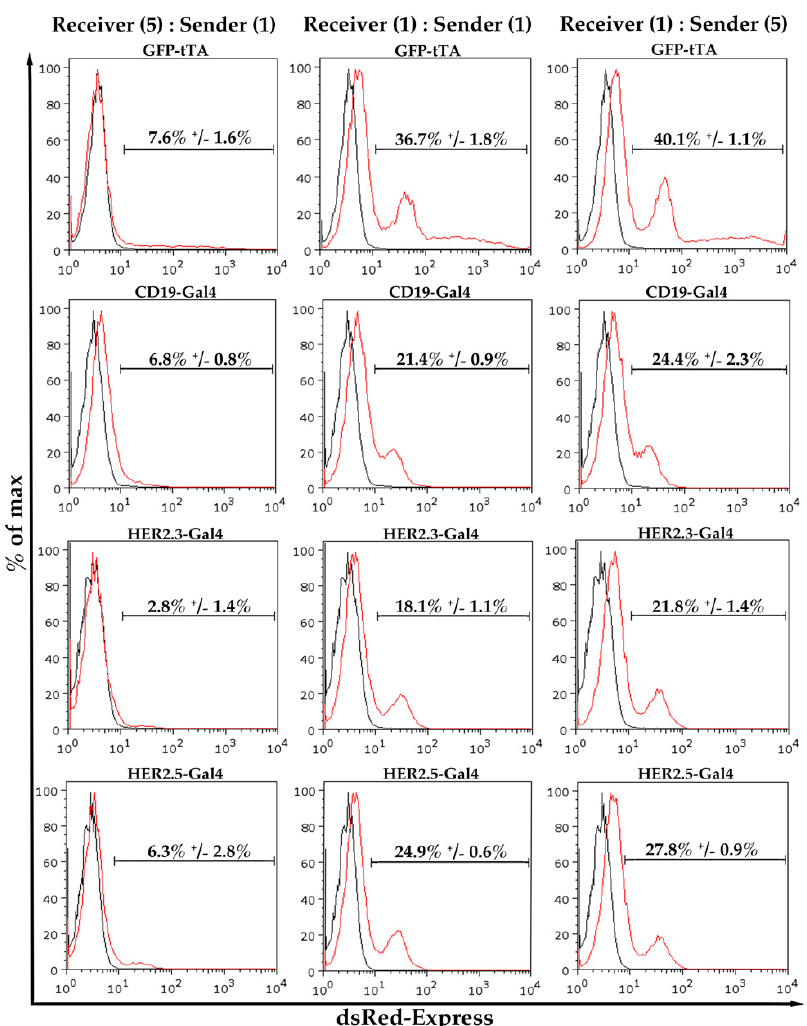
Figure 2. Effect of the ratio of receptor-presenting receiver cells to antigen-presenting sender cells on synNotch receptor activation: To determine the ideal ratio, three different ratios (5:1, 1:1, and 1:5) of synNotch-receptor (targeted against GFP, CD19, HER2.3, or HER2.5) expressing receiver cells were co-culture with their corresponding antigen expressing cells to induce dsRed-Express expression. Receiver cells were quantified for dsRed-Express expression after 48 h by flow cytometry ( n = 3).